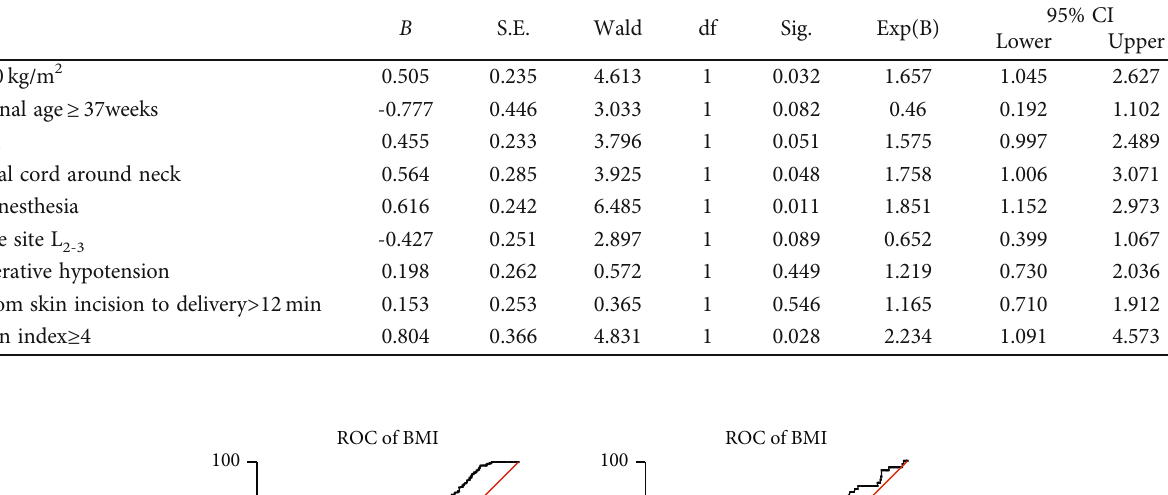
Table 5: Multivariate logistic regression analysis of risk factors for poor neonatal prognosis.